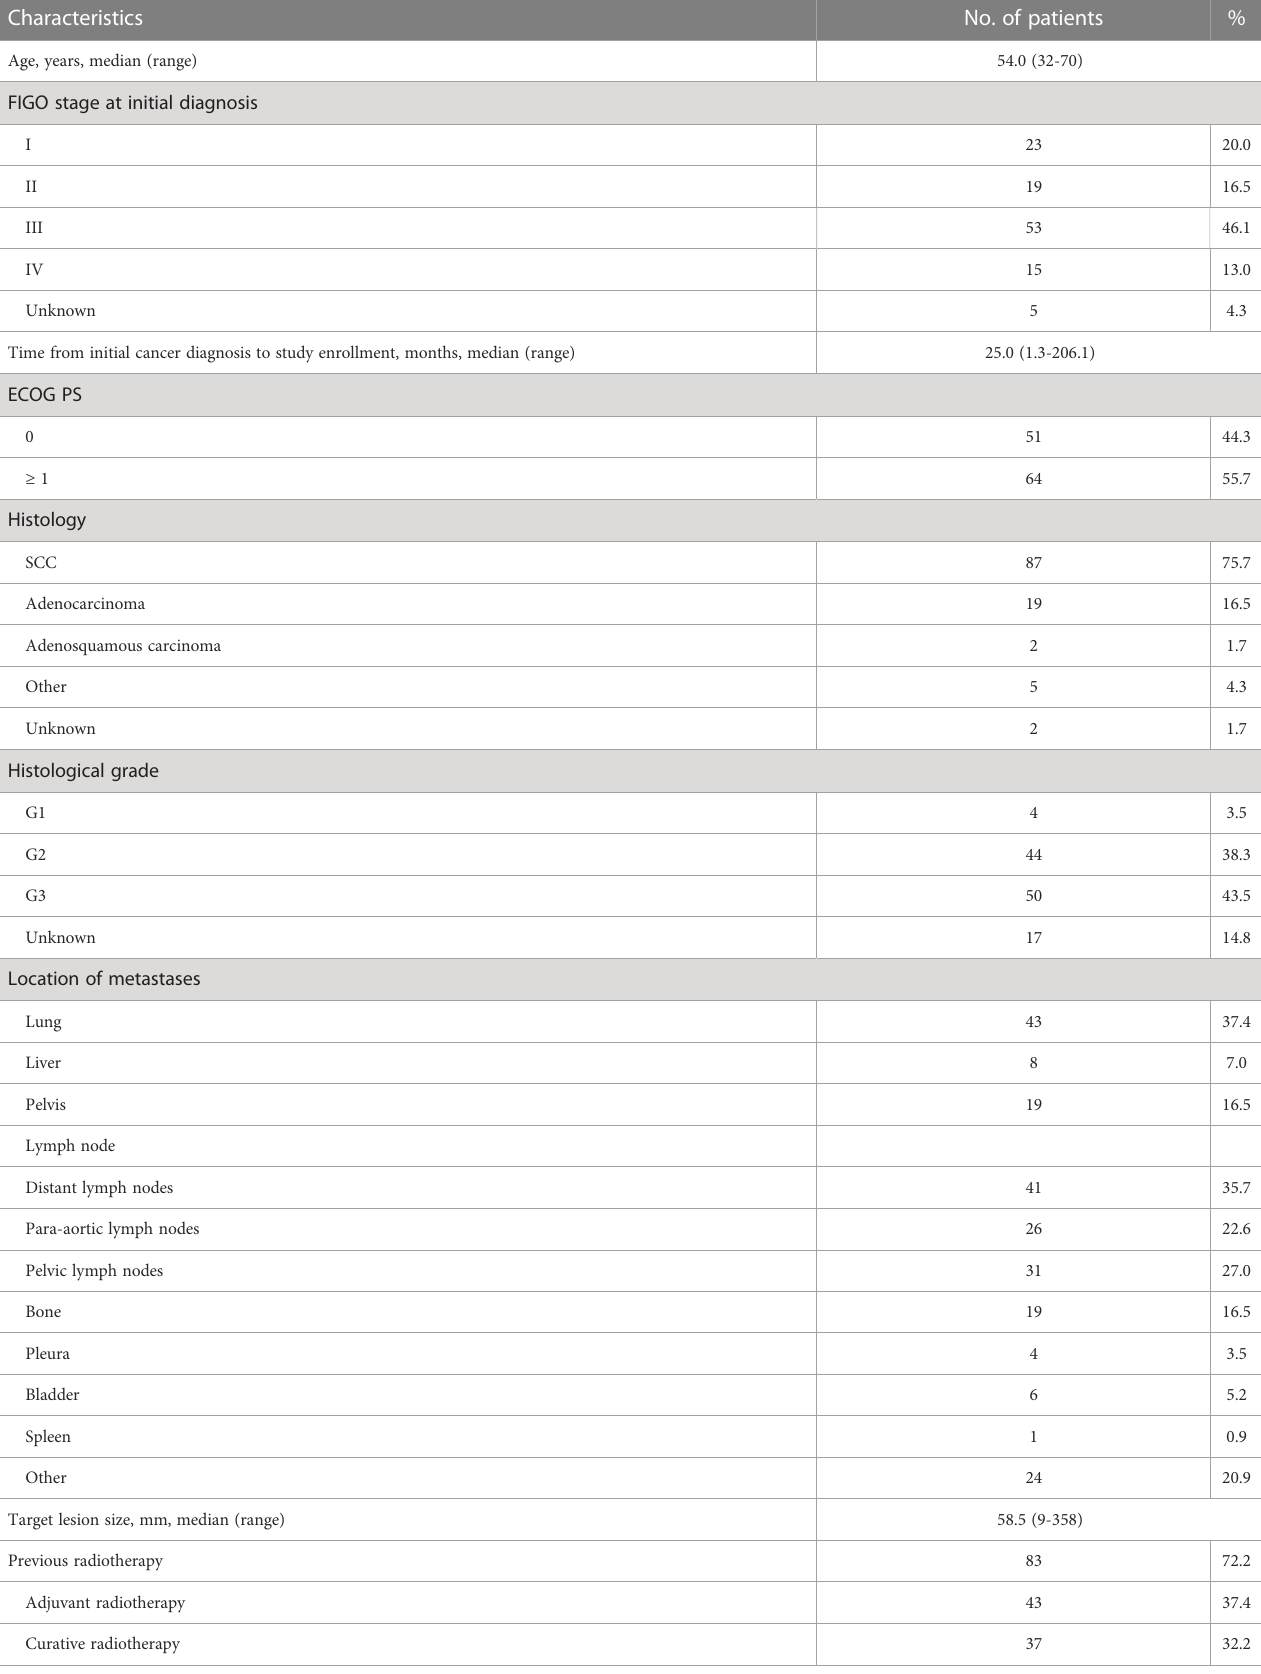
TABLE 1 Baseline characteristics (n =